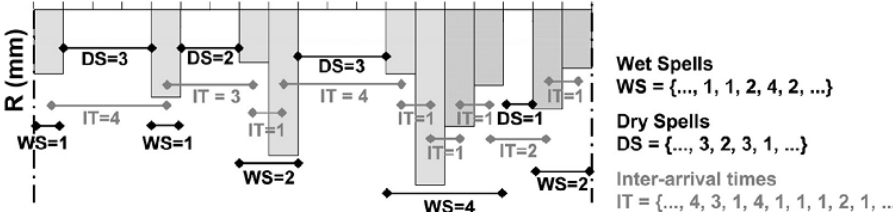
Figure 1. Sketch of inter-arrival times ( IT ), dry spells ( DS ) and wet spells ( WS ). Reprinted with permission from ref. [32], Copyright 2014, Elsevier (Amsterdam, The Netherlands).